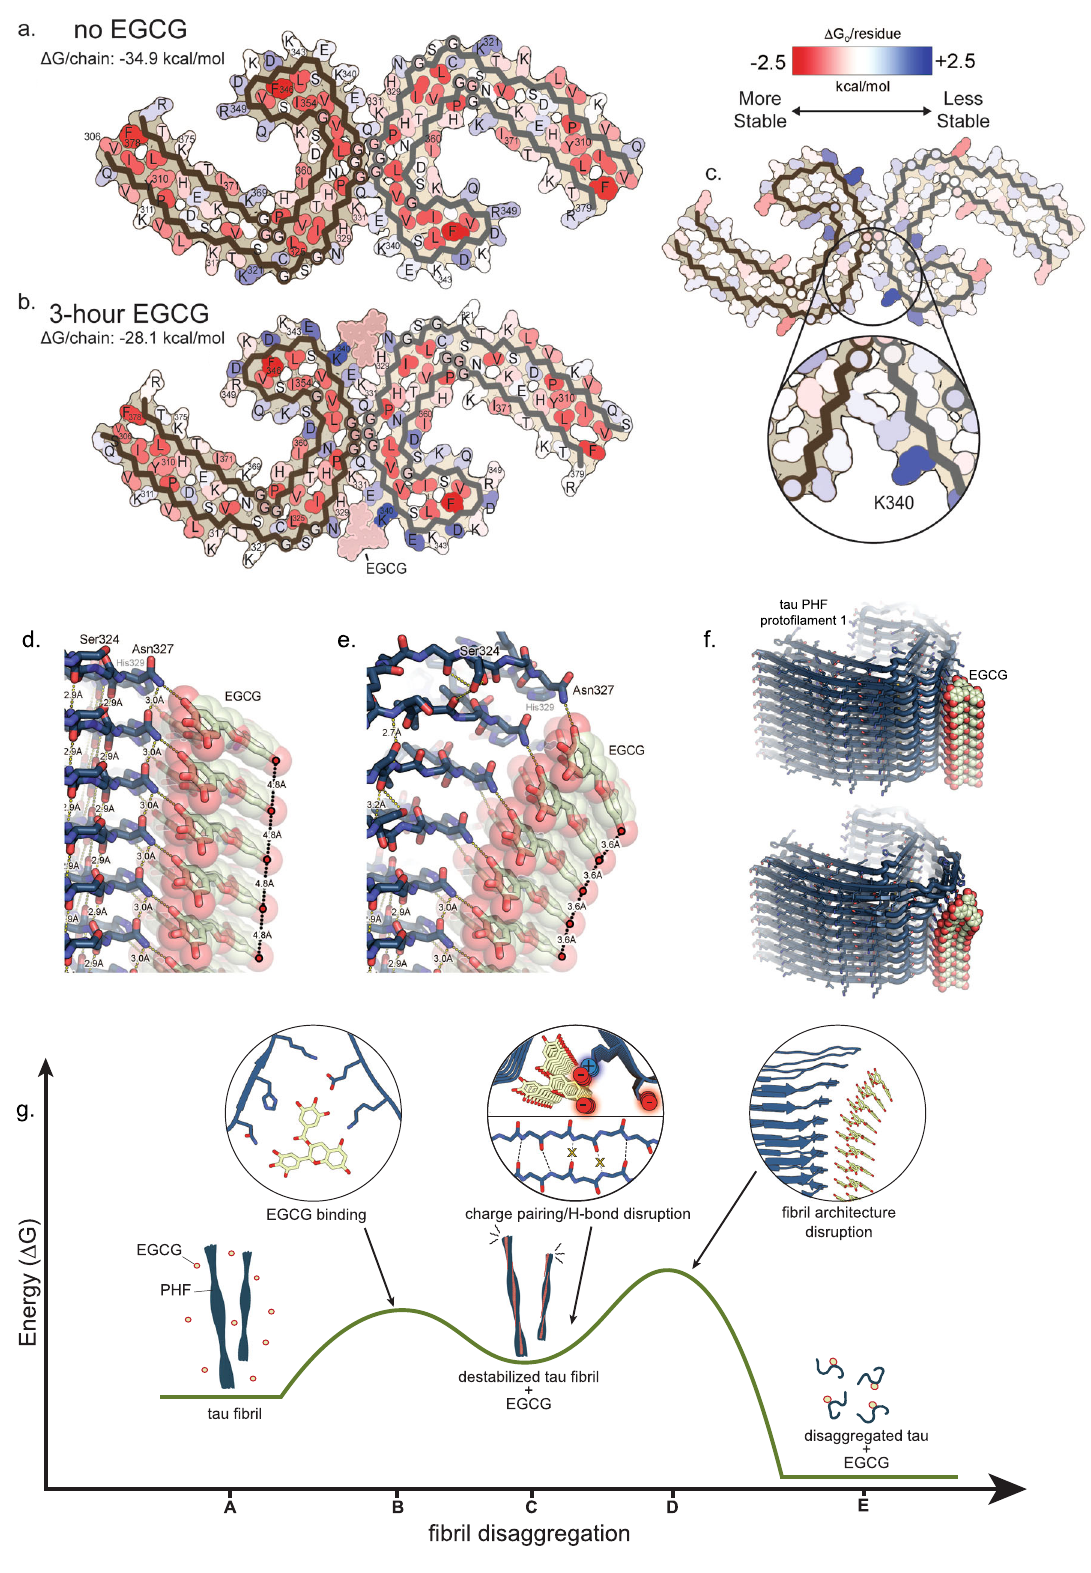
Here we have determined the intermediate structure of AD tau fi brils on the pathway to EGCG-driven disaggregation. Considering the identi fi ed several tau-disaggregating molecules with physiochemical drug-like properties superior to those of EGCG. Further screening or